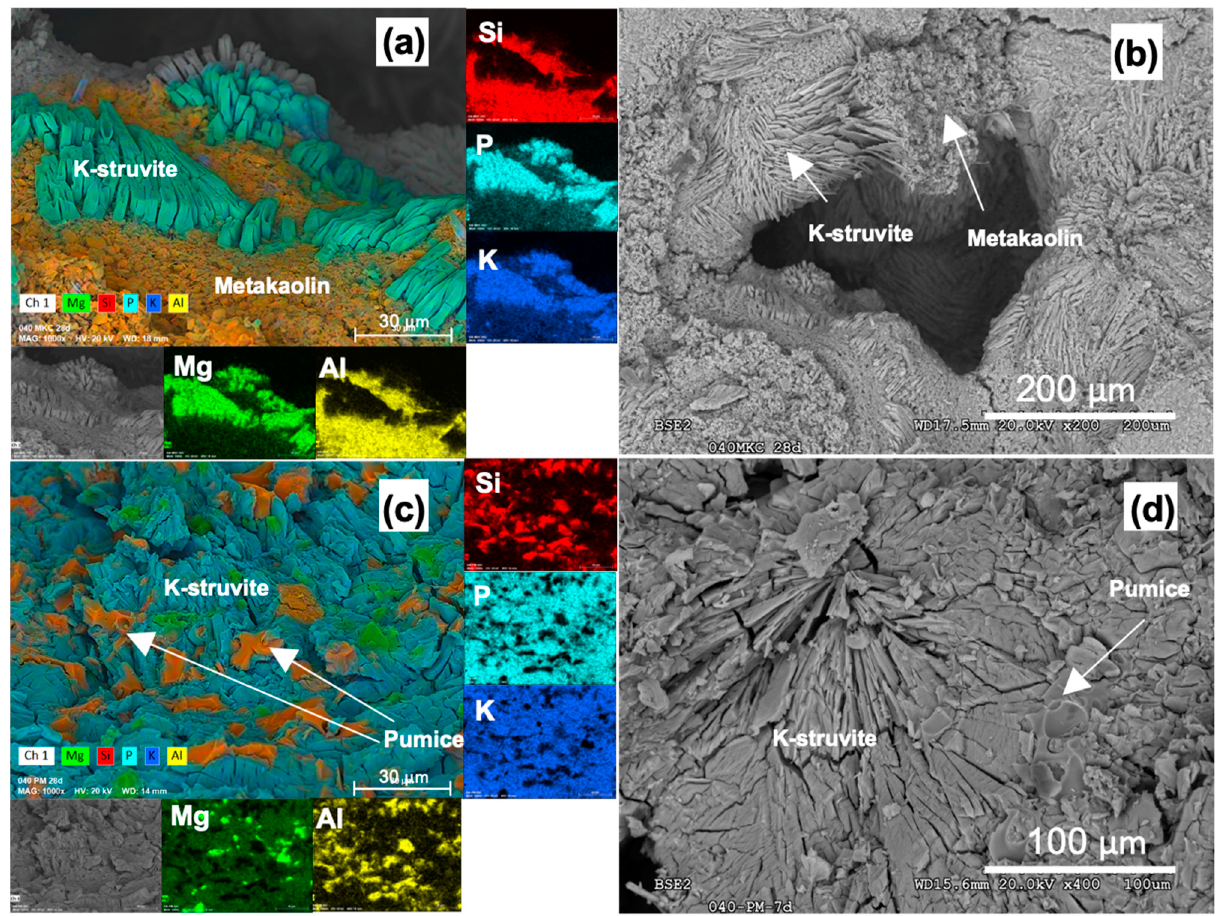
Figure 6. SEM images of MKPC pastes with MKB ( a , b ) and PM ( c , d ) fillers in fresh fractures. For the formulations with MKB (Figure 6a,b) the morphology presented well devel ‐ oped crystal aggregates with networks of layered K ‐ struvite crystals surrounded by amor ‐ phous metakaolin fulfilling the space between layers. This could explain the higher com ‐ pressive strength of the MKPC blended with this filler by developing a denser microstruc ‐ ture, filling the cracks and generating a less porous structure. Additionally, the develop ‐ ment of crystal growth of the K ‐ struvite crystals layered in random orientation could lead to a higher mechanical strength due to the absence of potential weakened planes in the structure of the MKPC. Particles of massive aluminosilicate aggregates (no crystalline habit evidence) attributed to pumice can be observed embedded in the MKPC matrix (Fig ‐ ure 6d). Green spots of unreacted MgO can also be observed in Figure 6c, indicating its incomplete reaction, in agreement with the results obtained by the XRD analysis. None ‐ theless, in both cases, a good bonding between the filler and the MKPC matrix and absence of new mineral phases was observed. Similar structures were found for the MKPC formulations with WO and FA fillers as shown in Figure 7. In the pastes prepared with WO (Figure 7a), rod shape crystals of wol ‐ lastonite can be observed embedded in the MKPC matrix. Glassy morphologies were also found in this sample, as shown in Figure 7b with dashed line red square markers. Punc ‐ tual EDX semiquantitative analyses of these areas were performed, finding relatively high contents of Ca (between 3 and 10%) and S (between 1.8 and 13.7%), possibly attributed to secondary minerals in the filler WO. Nonetheless, despite the minor contents of Ca, Si, and Al detected in the K ‐ struvite crystals with the different types of fillers studied in this work, no new mineral phases were found by the XRD analyses, indicating the amorphous character of this phase and its negligible impact.